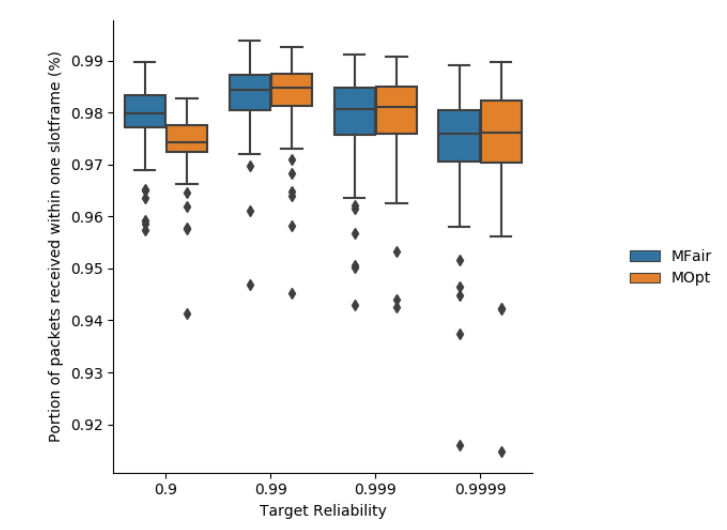
Figure 9. Percentage of packets delivered in one slotframe with MFair and MOpt